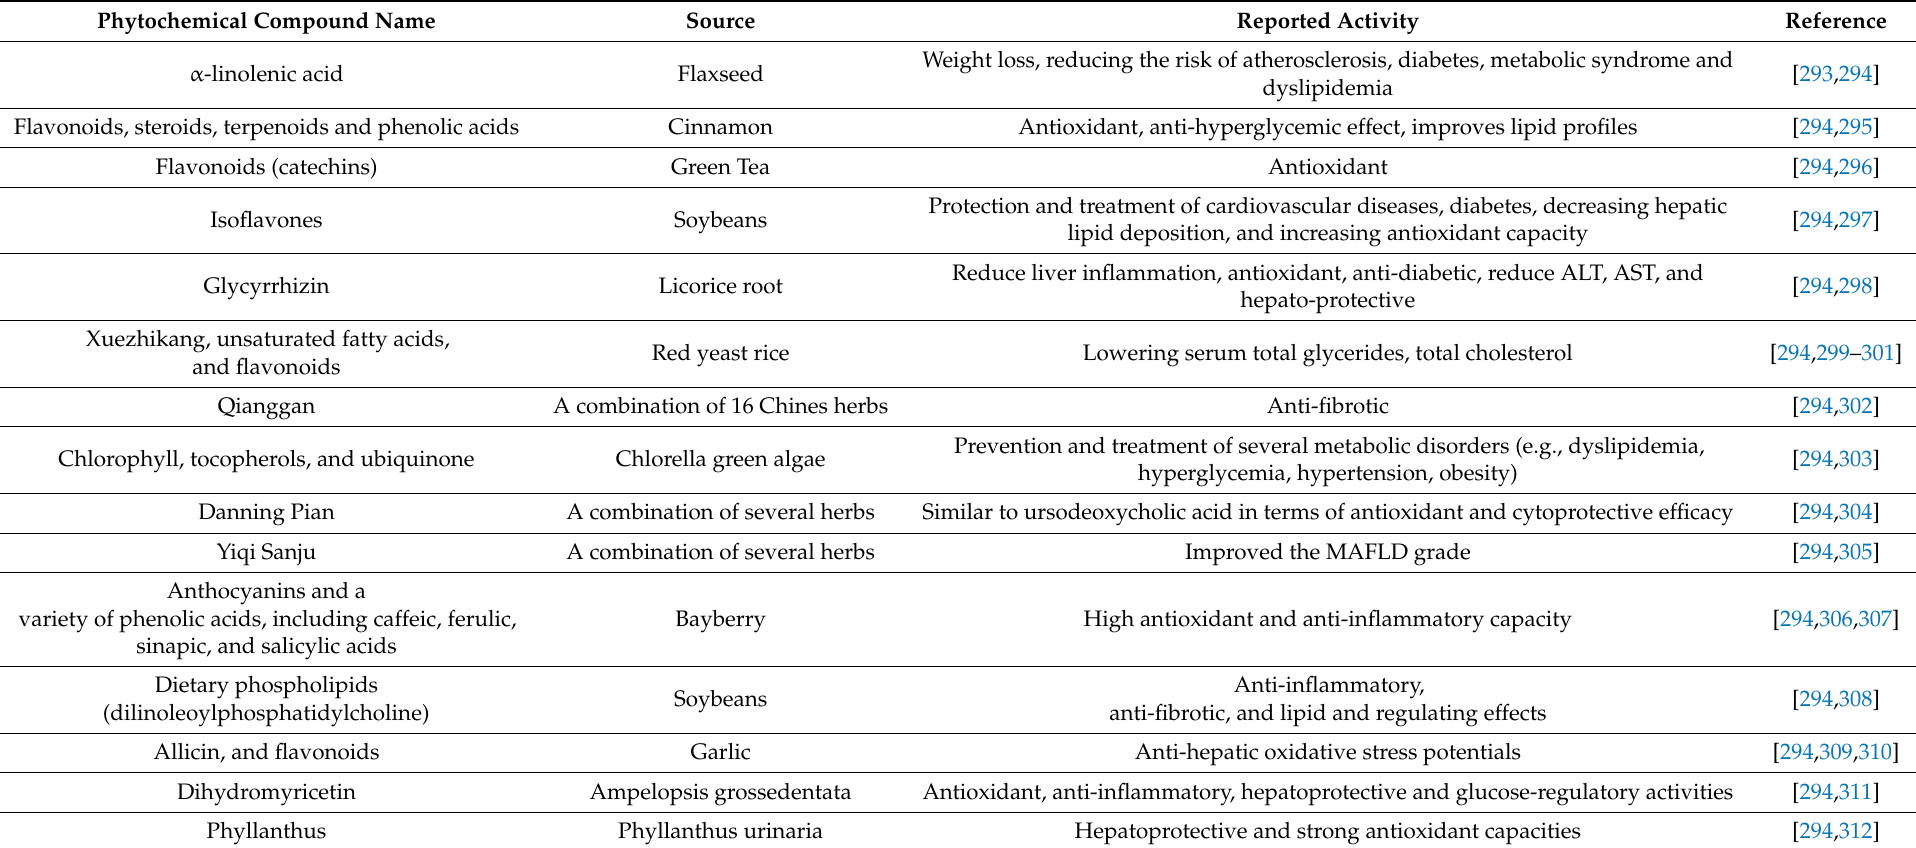
Table 1. Suggested phytochemicals for future anti-MAFLD nanocarrier research in relation to it being active and/or excipient with synergetic